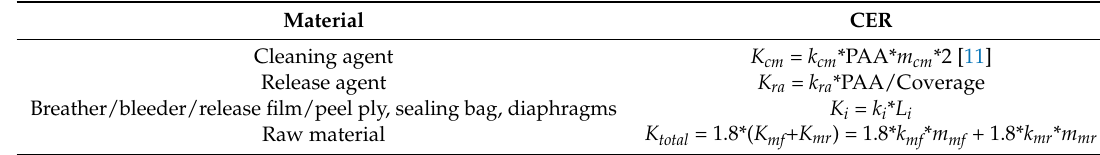
Table 3. Material